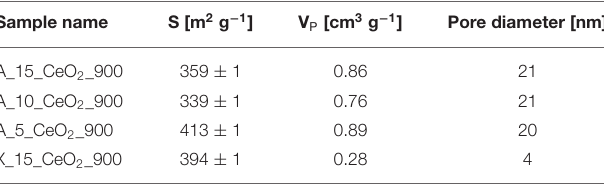
TABLE 2 | Surface area, S, pore volume, V P , and pore diameter values for the aerogel and xerogel nanocomposites obtained by N 2